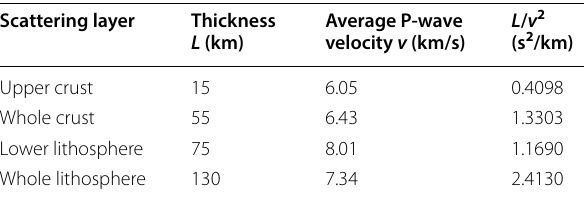
Table 1 Parameters of L / v 2 for four possible scattering layers beneath NTS